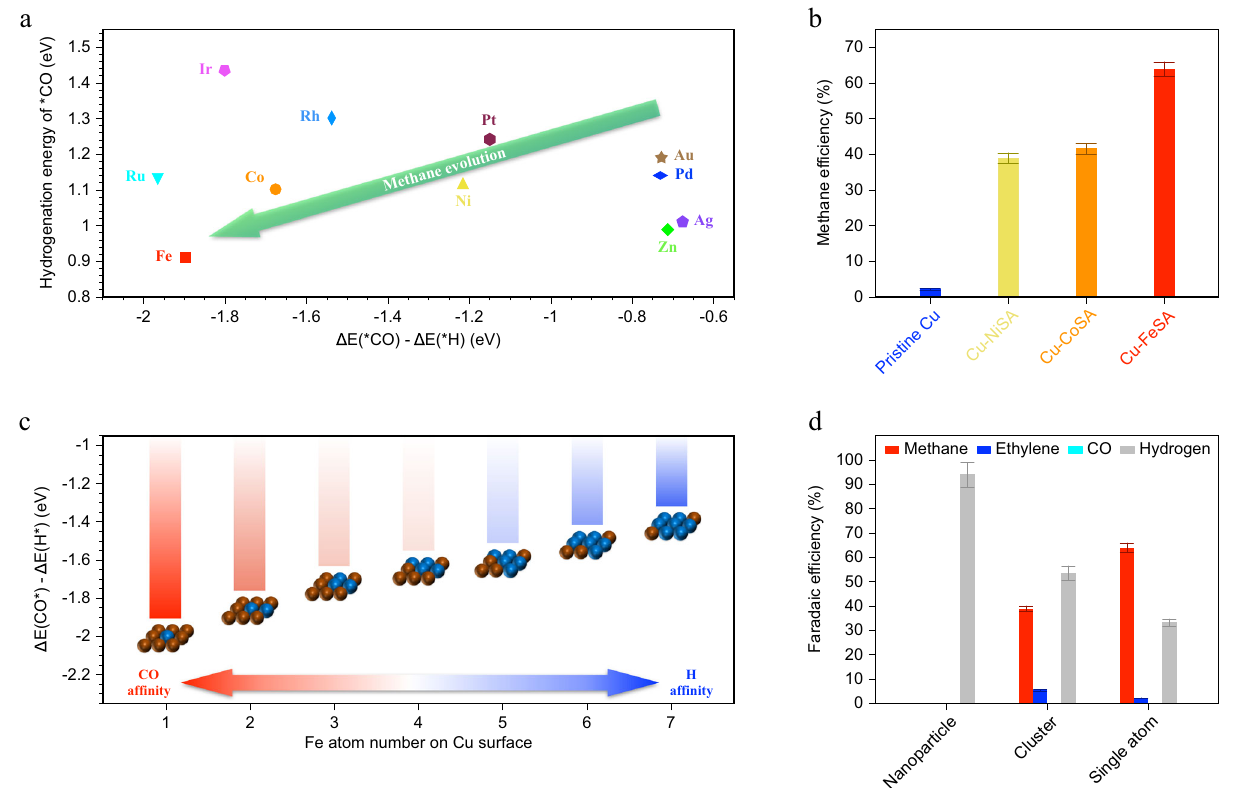
Fig. 1 Calculations and catalytic activities for single-atom-anchored copper. a Comparison of adsorption energy and hydrogenation of *CO on various single-atom catalytic sites. b Catalytic methane activities of pristine Cu vs. various single-atom-anchored copper catalysts for CO 2 reduction reaction. c Effect of iron domain sizes in the copper surface on the adsorption energies of *H and *CO. d Catalytic activities of various iron-dispersed copper materials, including nanoparticle, cluster, and single-atom forms. The error bars represent 1 s.d. on the basis of three independent